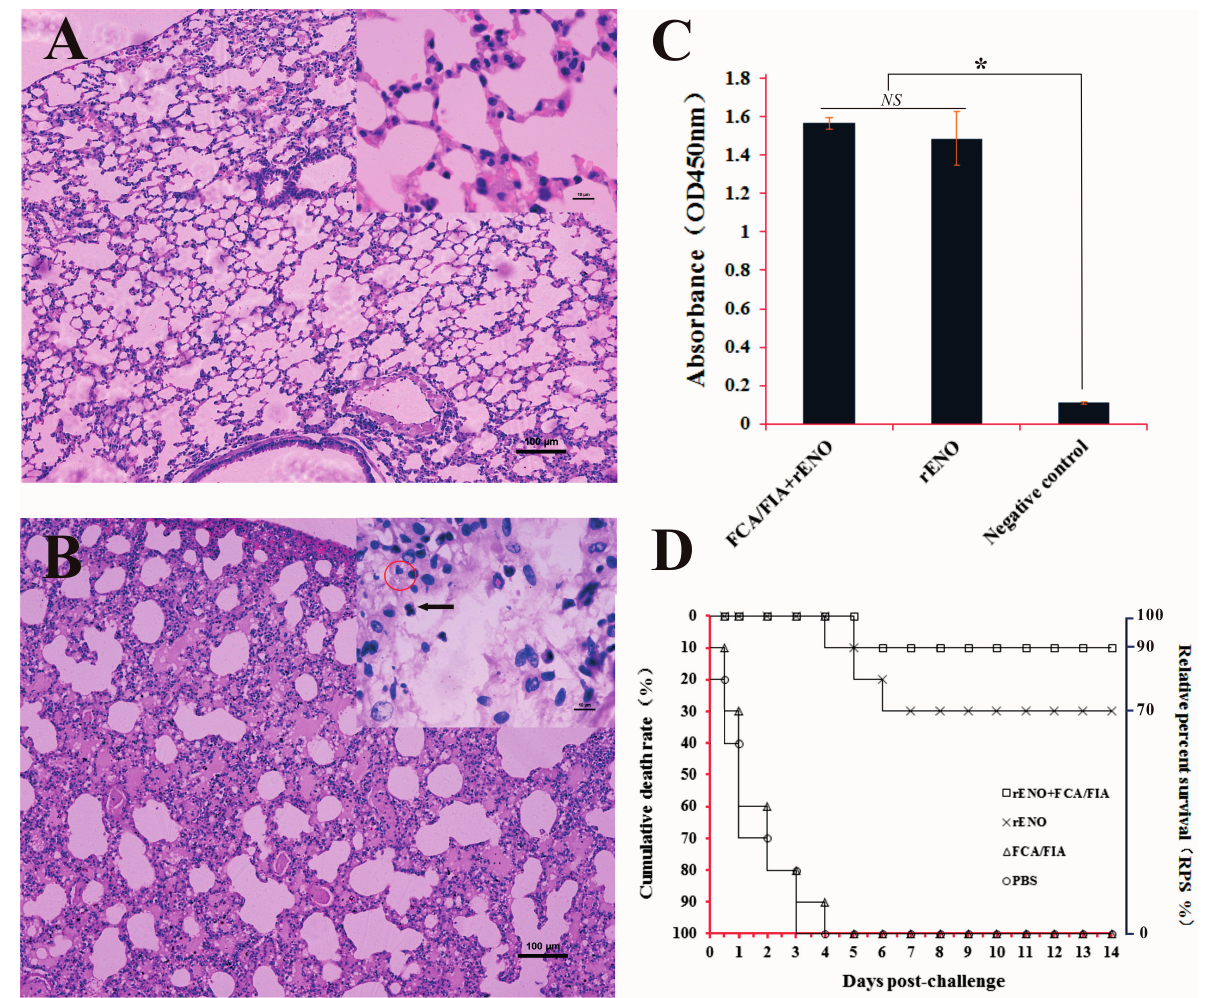
Figure 7. Immunoprotective analysis of rENO against S. iniae in mice. ( A , B ) Histopathological assessment of lung of immunized mice and control mice. The structure of lungs, were intact and no obvious pathological changes in the immunized group ( A ); However, in the control group, the alveolar walls were thickening and some epithelial cells were shedding; a large number of inflammatory cells infiltrated (as indicated by solid arrow) and the homogeneous red serous exudation led to alveolar lumen narrowing or even disappearance; the bacteria-like structures were observed in macrophages (as indicated by red circle); ( C ) Antibody level analysis of the immune mice. Analysis of total IgG with antiserum 1:100 dilution in response to rENO, the PBS injected mice serum were as the negative control. The antibody levels of immune mice by rENO (with or without adjuvant) were significant higher than the negative control mice ( p < 0.05). The differences were not significant between rENO immune mice with adjuvant and without adjuvant ( p > 0.05); ( D ) RPS rates in immunized mice. Mice were immunized two times with rENO-FCA/ FIC ( □ ), rENO (×), FCA/FIC ( ∆ ) or PBS (O), followed by challenge with S. iniae (3.2 × 10 6 cfu/mice). Each group consisted of 10 mice. All mice were monitored for mortality for 14 days after the challenge, and the cumulative mortality rates ( left side) corresponding to RPS rates ( right side) are shown. * p < 0.05. NS denotes no statistically significant difference, and error bars indicate